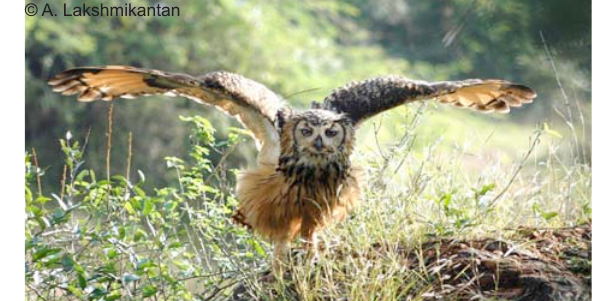
Image 9. Wing flapping (Human distance from nest < 10 m).